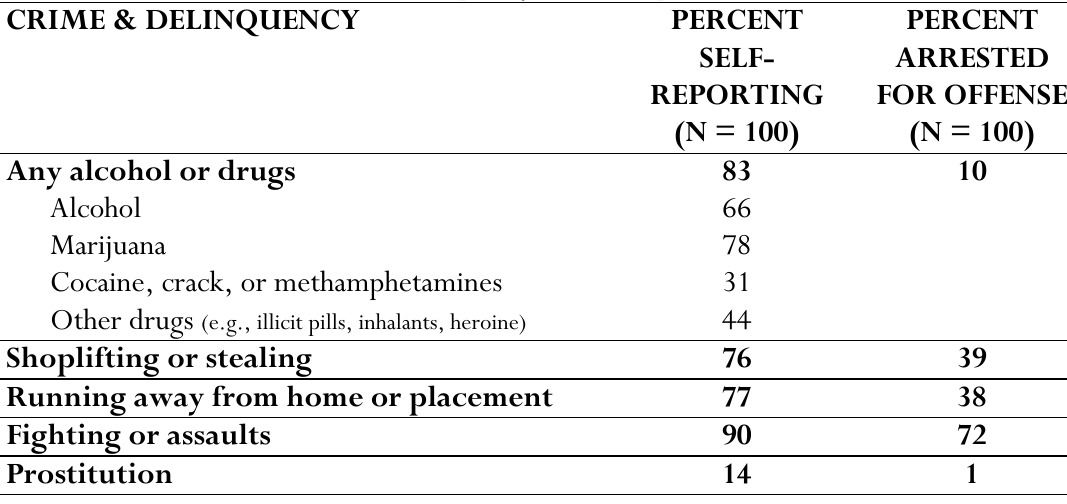
Table 7: Prevalence of Crime & Delinquency in Self-Reports and Arrest Records CRIME &